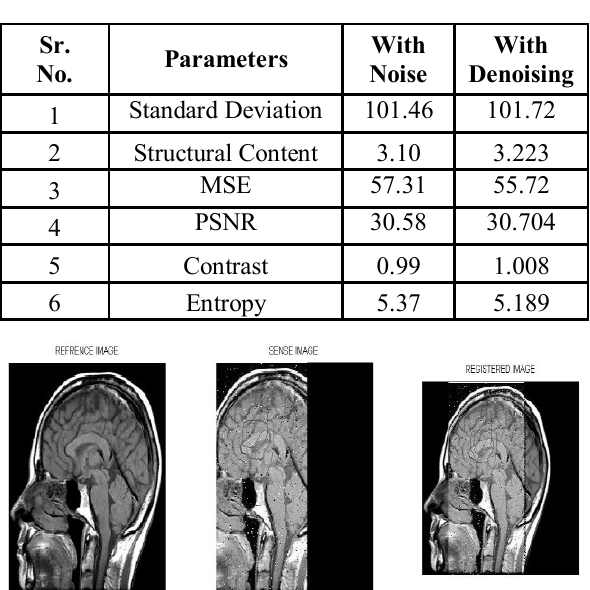
Fig 3. Image Registration for Chest CT with Denoise effect Horizontal movement: 79, Vertical movement: 43, Rotated Fig 6. Image Registration for Lungs CT with Noise effect angle: 180ᴼ The composite algorithm applied on Head CT has successfully registered for sense image with partial data, without exact angle shown in figure 10 and scaling effect shown in figure 11. Table 1. Chest CT: Comparision of registered image with and without denoising effect Sr. Fig 7. Image Registration for Lungs CT with Denoise effect Horizontal movement: - 44, Vertical movement: -70, Rotated angle: 180ᴼ. Table 3. Lungs CT: Comparision of registered image with and without denoising effect